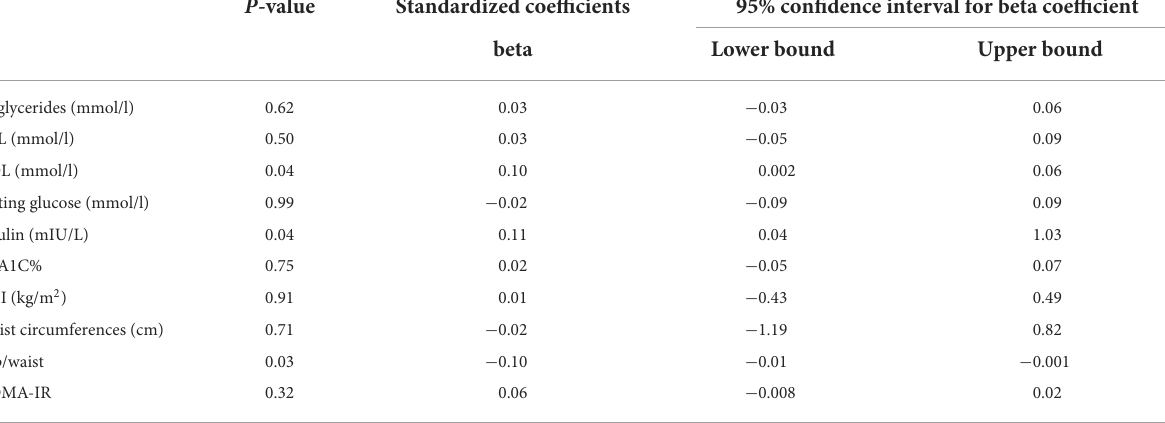
TABLE 6 Regression analysis of night sleep duration with metabolic components after adjustment for age and afternoon siesta (napping).